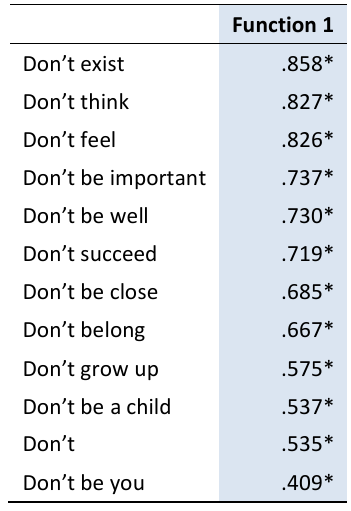
Table 3: Structure matrix of the discriminant function